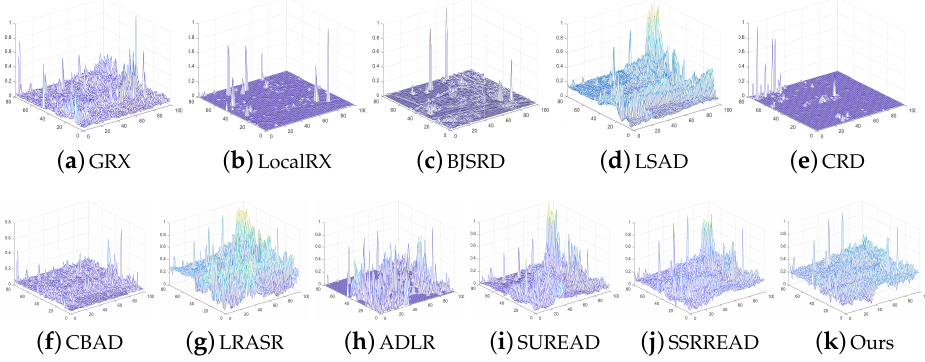
Figure 11. 3-D mesh of the detection algorithms for the Urban dataset. The last two real-world datasets, Sandiego60 and Sandiego80, are both from the San Diego Airport dataset. The 18 aircrafts in Sandiego60 are smaller in size and the study area has a relatively low background complexity. There are three aircrafts in Sandiego80, larger than those in Sandiego60, but the background objects presented are more